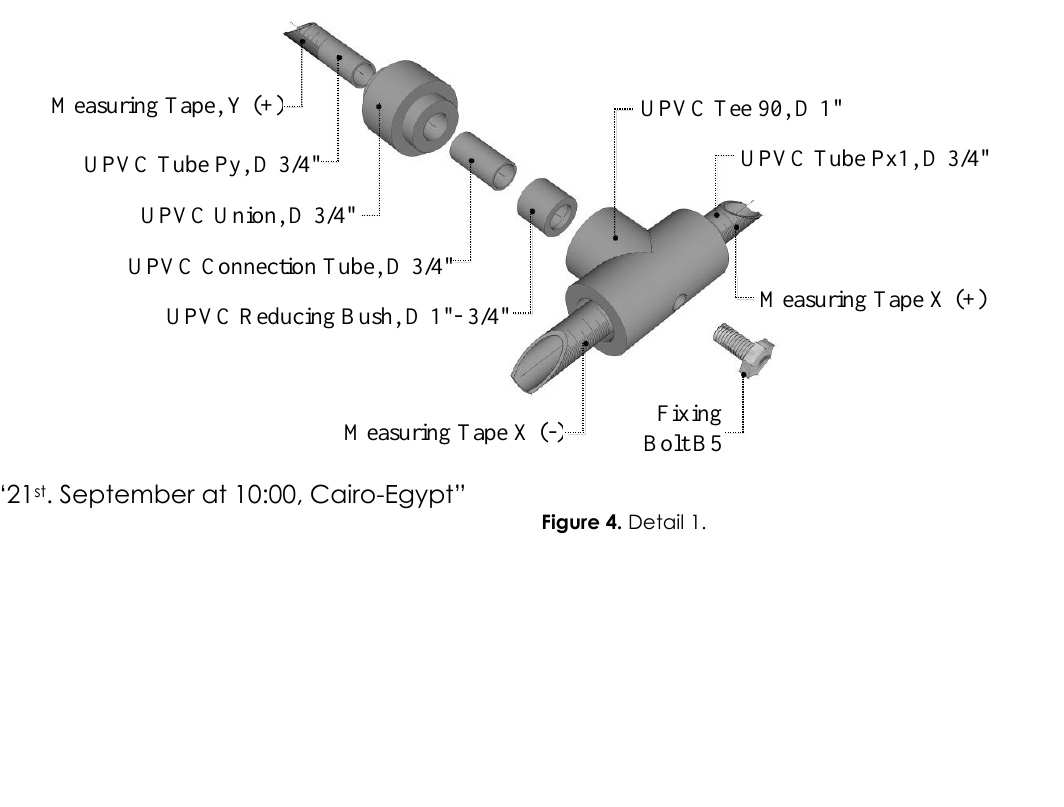
Figure 3. The proposed heliodon illustrates the effect of the sunlight on a building model .